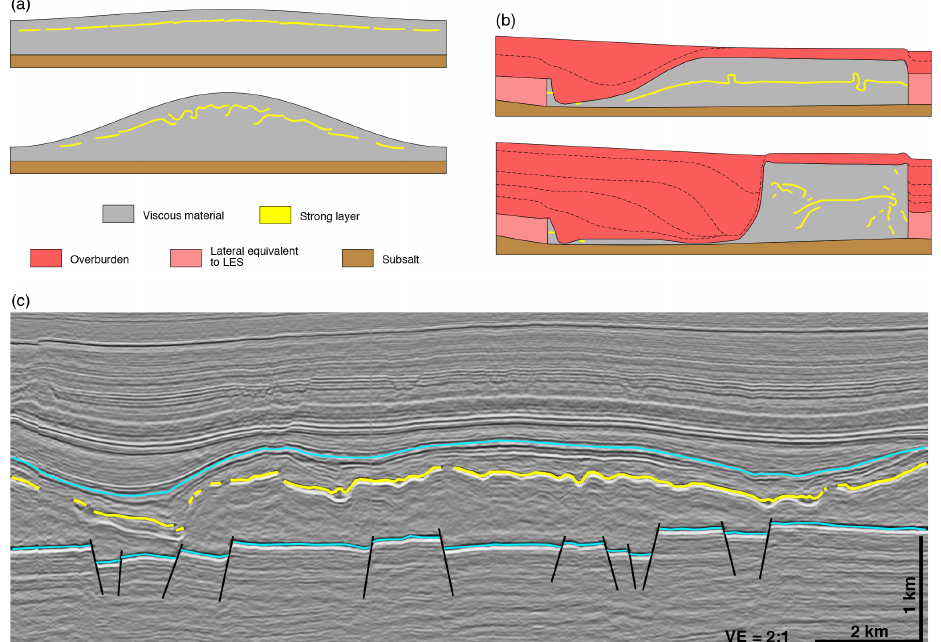
Figure 11. Examples of differential loading of salt with internal competent beds (yellow): (a) simplified sequential results of finite-element model with subsidence on both ends and inflation of a central salt pillow – the early deformation of the strong layer (top) is dominated by boudinage, but further deformation leads to folding and overlap of the boudins in the pillow (adapted from Raith, 2017); (b) simplified sequential results of numerical model with progradational loading (indicated by black dashed lines) and consequent inflation – the strong layer is pulled almost completely apart beneath the depocenter and is first folded and then thrusted and disrupted in the inflated body (adapted from Albertz and Ings, 2012); (c) 3-D depth-migrated seismic profile (vertical exaggeration 2 : 1) from the Groningen High of the onshore Netherlands showing a gentle salt pillow of the Zechstein salt (between cyan horizons) between two Triassic depocenters – the Z3 stringer (yellow) is mostly continuous and slightly folded within the pillow but more broken up beneath the depocenters (adapted from Strozyk et al., 2014).